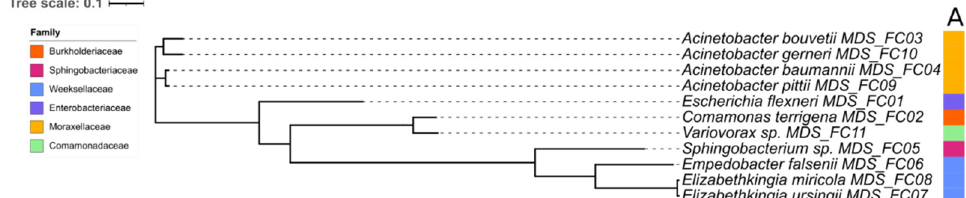
Figure 2. Phylogenetic tree of representative metagenome-assembled genomes using the concatenated protein alignment of genes from GTDB-tk [28]. The inside node labels represent taxonomy at the species level. The inner column (A), represents taxonomy at the family level. The size of the scale indicates relative evolutionary divergence value for taxa at each taxonomic rank.